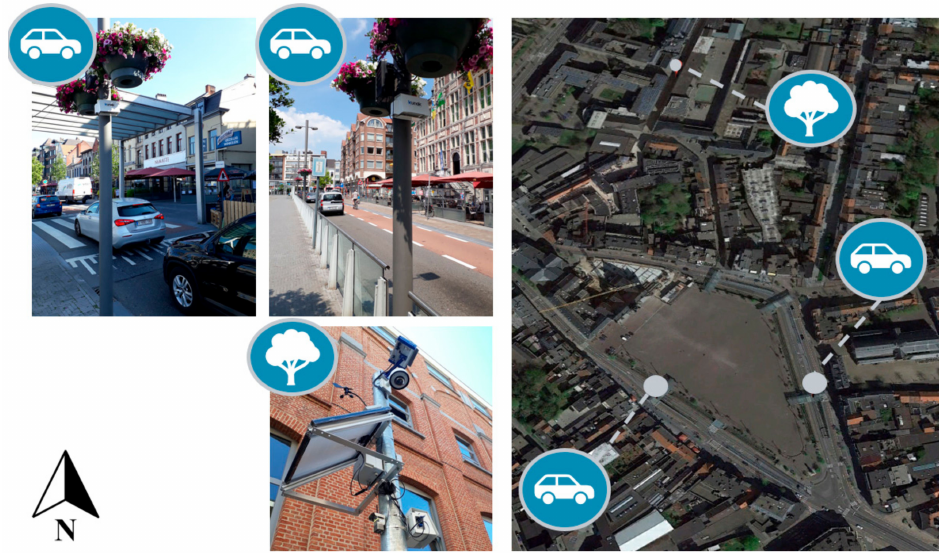
Figure 3. Monitoring locations (central city square (car) and background (tree)) of the Sint-Niklaas pilot, with associated visualizations of the Kunak and Airly